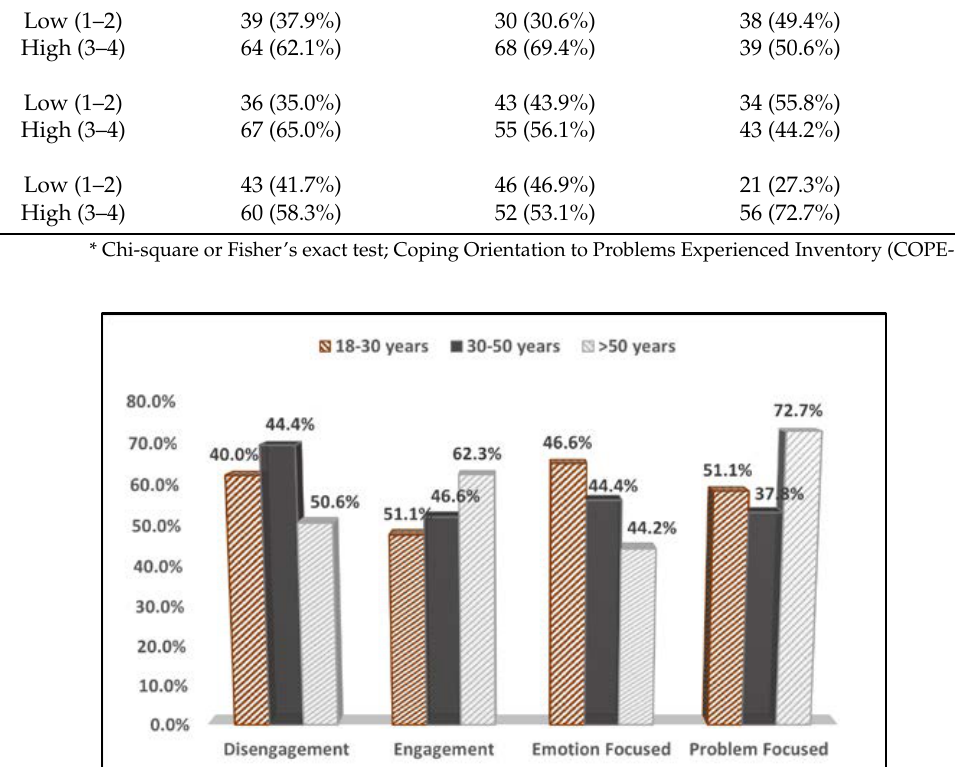
Table 4. Comparison of physical and mental quality of life scores based on the SF-12 questionnaire stratified by age group.